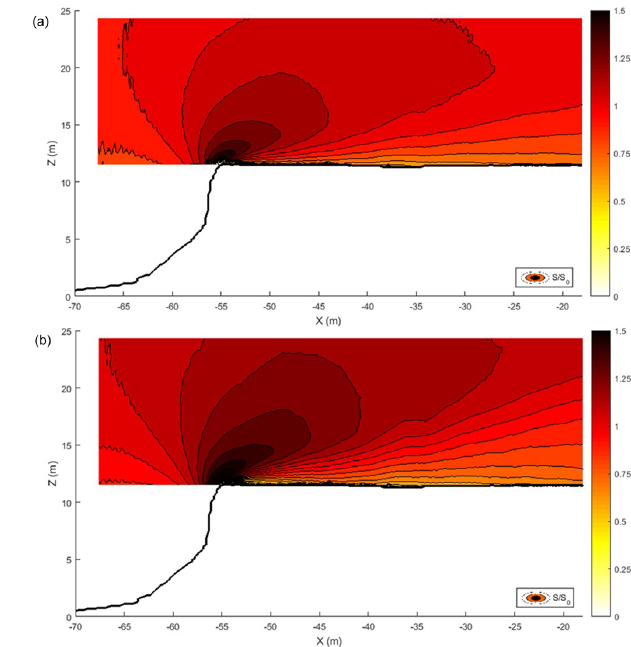
Figure 8. Contours of speed-up ratio ( S/S 0 ) for (a) U14RC1 and (b)